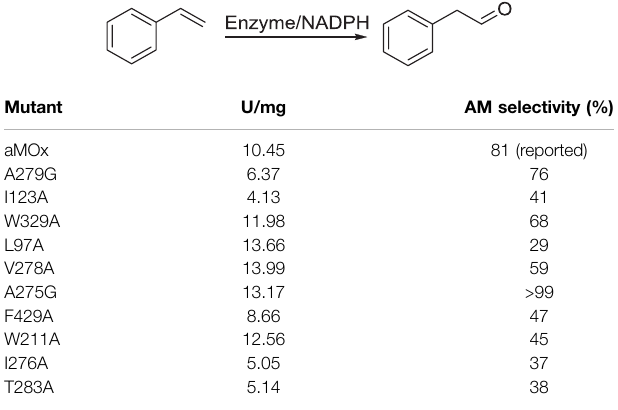
TABLE3| Speci fi cactivityandAMselectivityofaMOxanditsvariants.Allsamples were performed at least